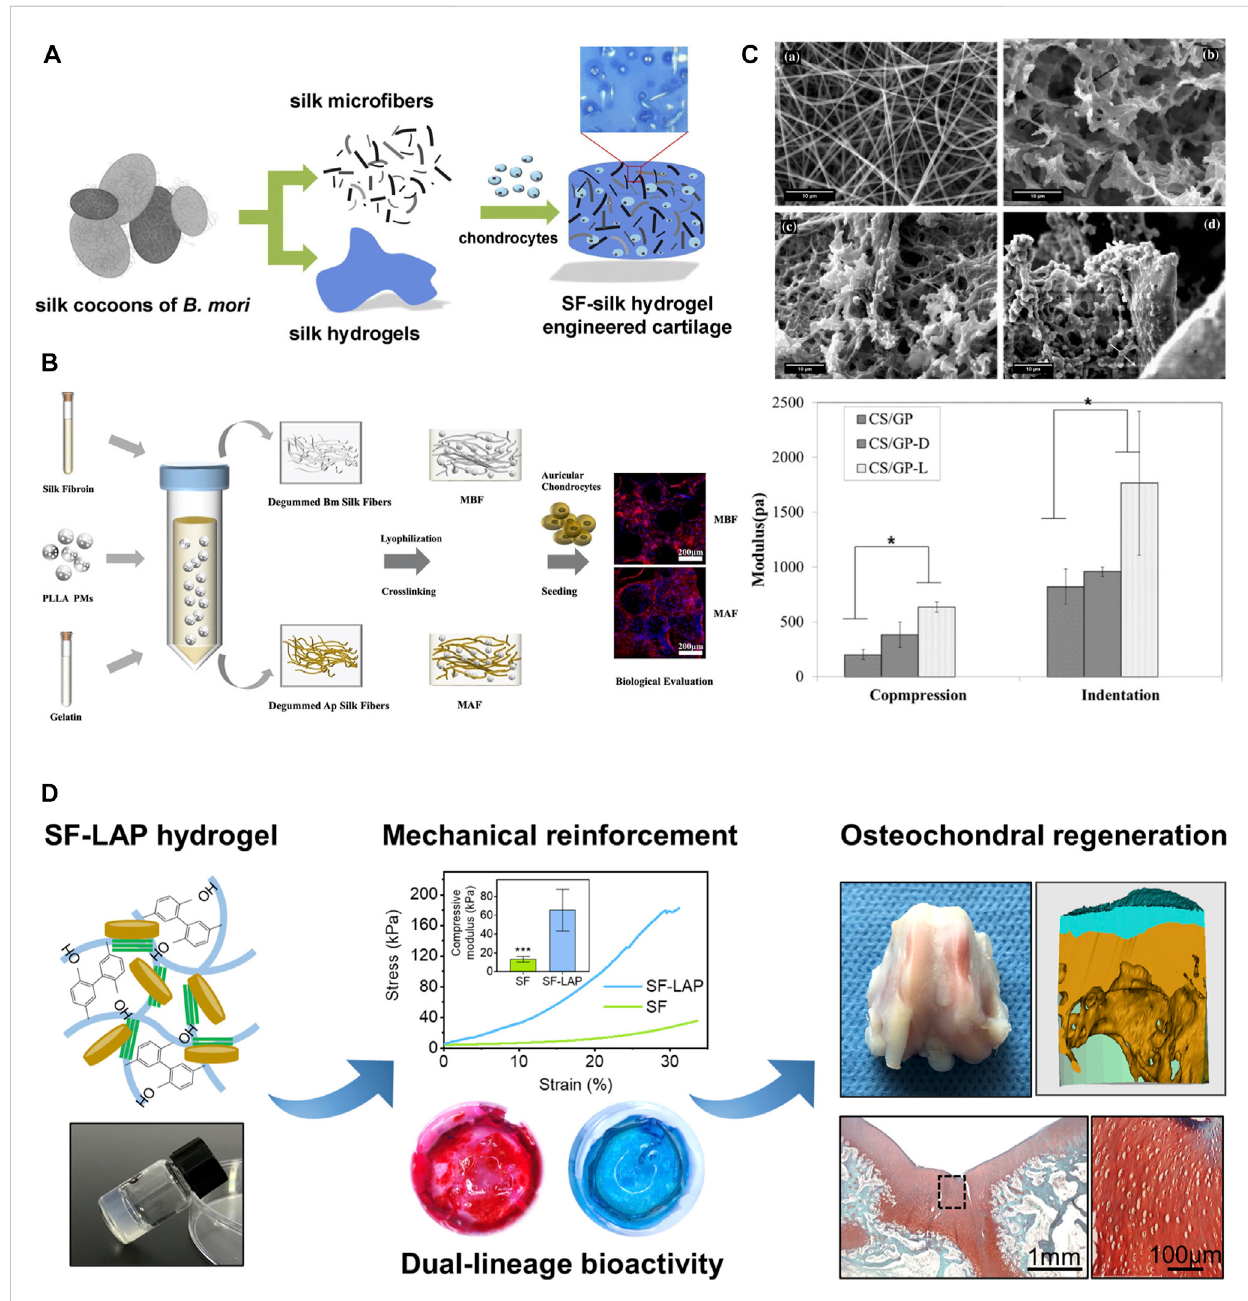
FIGURE 5 Mechanical reinforcement of silk protein hydrogels. (A) Silk micro fi ber reinforced silk hydrogels and their equilibrium and dynamic moduli with different silk fi ber lengths. (B) Two kinds of silk fi bers either from Bombyx mori (Bm) or Antheraea pernyi (Ap) and PLLA microspheres co-reinforced hydrogels for auricular cartilage tissue engineering. (C) SEM images of silk nano fi ber (top left), chitosan/glycerophosphate hydrogels (CS/GP) (top right), degummed chopped silk fi bers reinforced CS/GP (CS/GP-D) (bottom left), electrospun silk mats reinforced CS/GP (CS/GP-L) (bottom right) and their modulus. (D) Laponite (LAP) reinforced silk hydrogels for osteochondral regeneration. Adapted with permission from ref (Mirahmadi et al., 2013; Yodmuang et al., 2015; Yang et al., 2021; Zhang et al., 2021). Copyright 2013 Elsevier, 2015 Elsevier, 2021